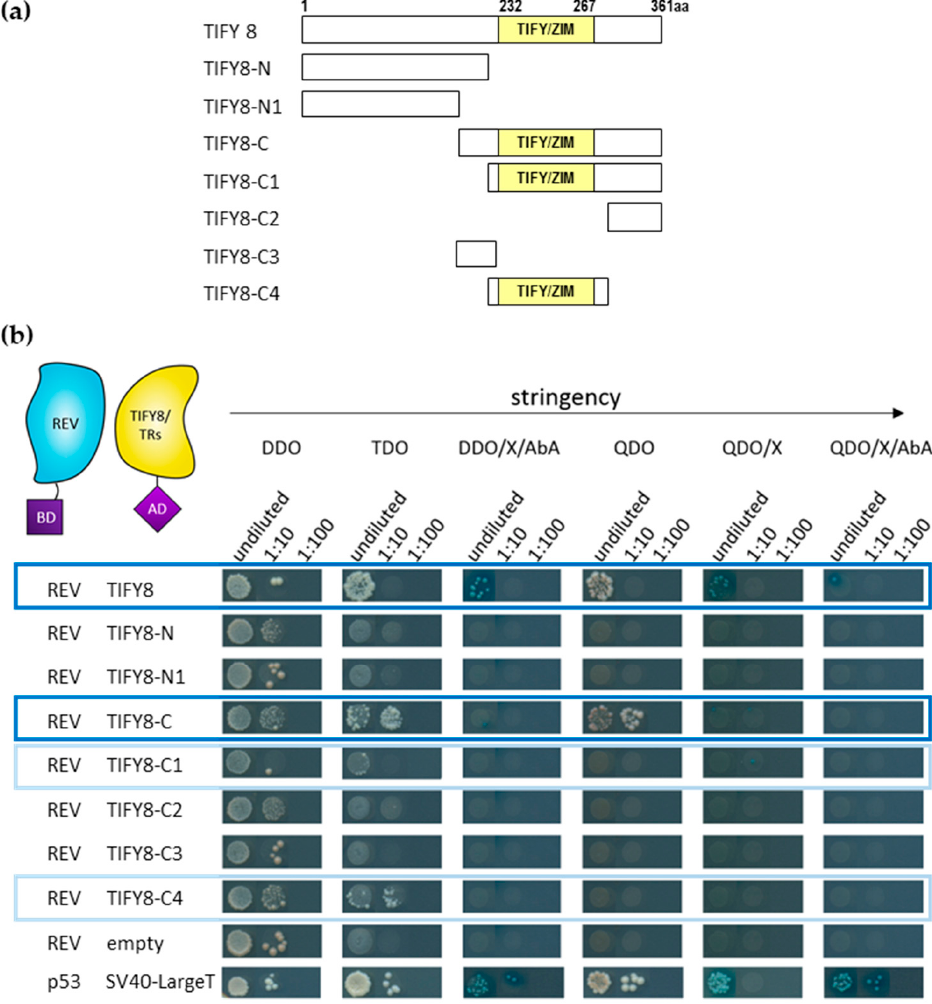
Figure 1. Yeast two-hybrid interactions between REV and TIFY8 and truncated proteins. ( a ) Scheme of TIFY8 and the truncated versions used in the yeast two-hybrid assay. The yellow box represents the TIFY/ZIM domain. TIFY8 full length (1 to 361aa), TIFY8-N (1 to 229aa), TIFY8-N1 (1 to 176aa), TIFY8-C (176 to 361aa), TIFY8-C1 (230 to 361aa), TIFY8-C2 (284 to 361aa), TIFY8-C3 (176 to 229aa), and TIFY8-C4 (239 to 283aa). ( b ) Representative yeast two-hybrid assay between GAL4-BD-REV and TIFY8, as well as a series of truncated versions of the TIFY8 protein shown in ( a ), fused with GAL4-AD. A serial 1:10 dilution of each transformed yeast was spotted onto control (DDO) and different protein–protein interaction selective media with increasing stringency. Blue boxes indicate interactions, and light blue boxes indicate weak interactions.